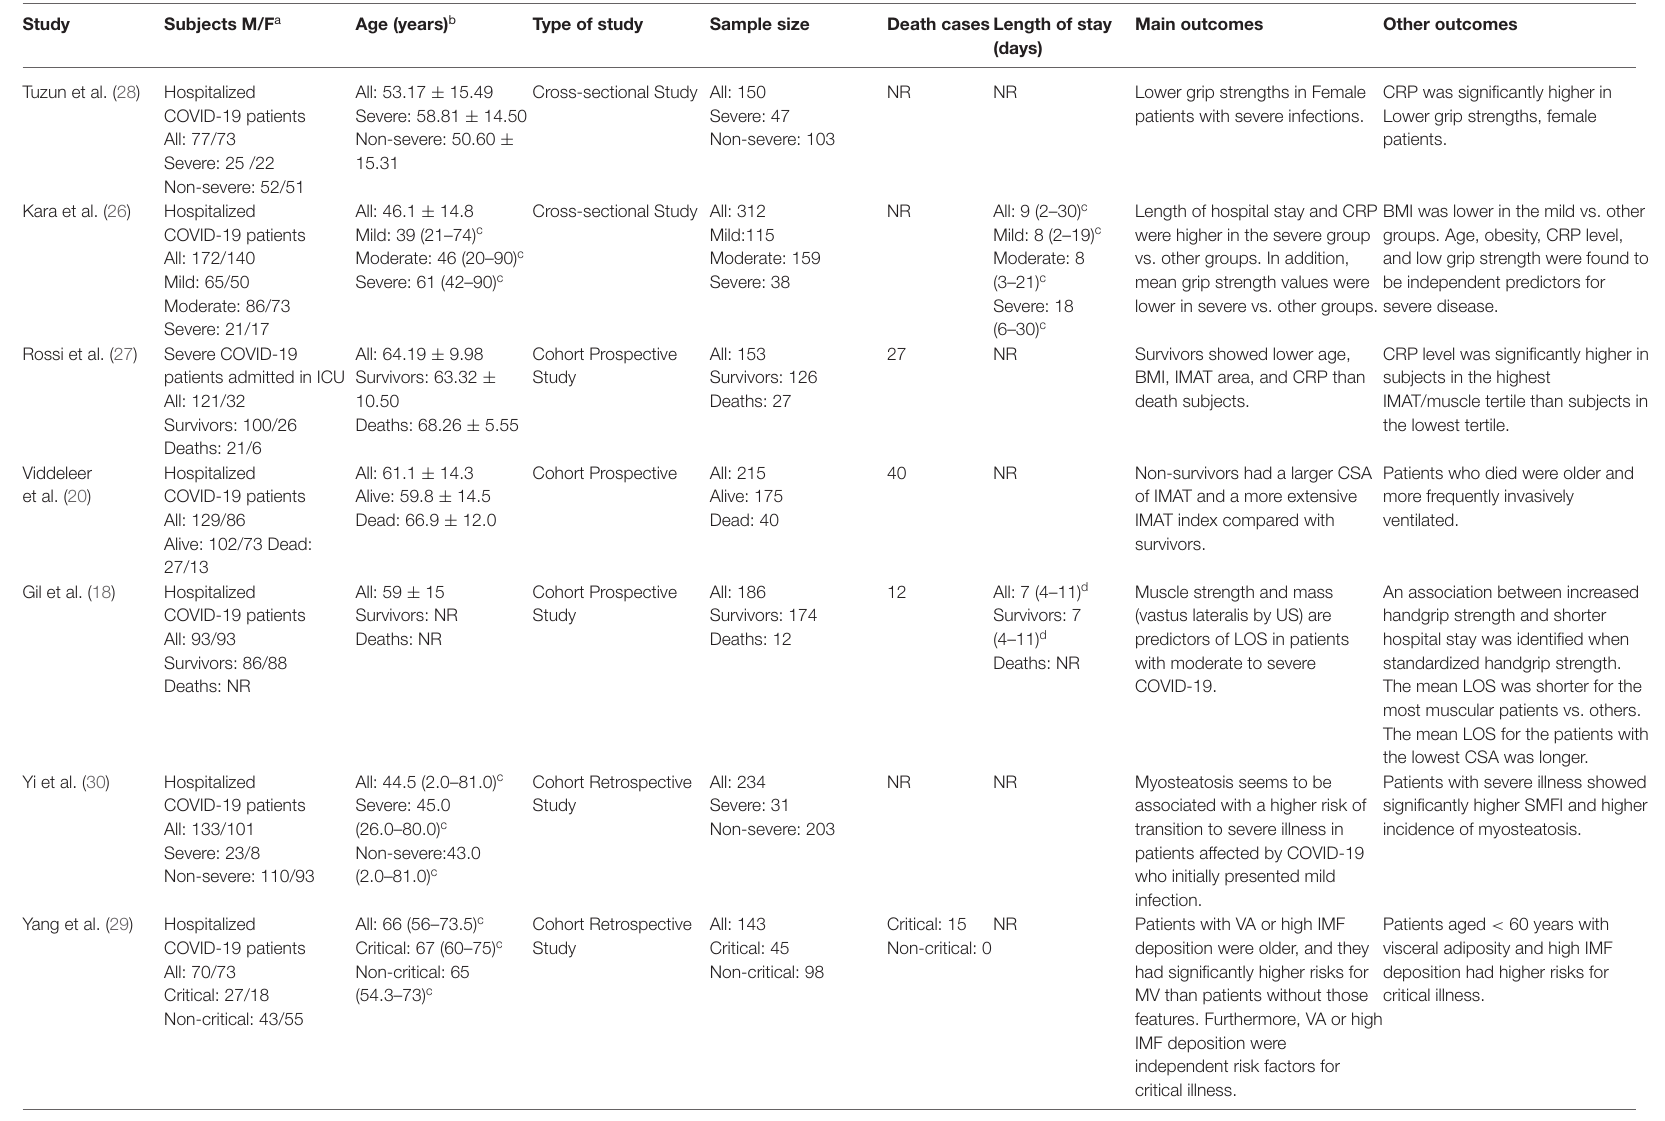
TABLE 2 | Main characteristics of the studies included in the meta-analysis.